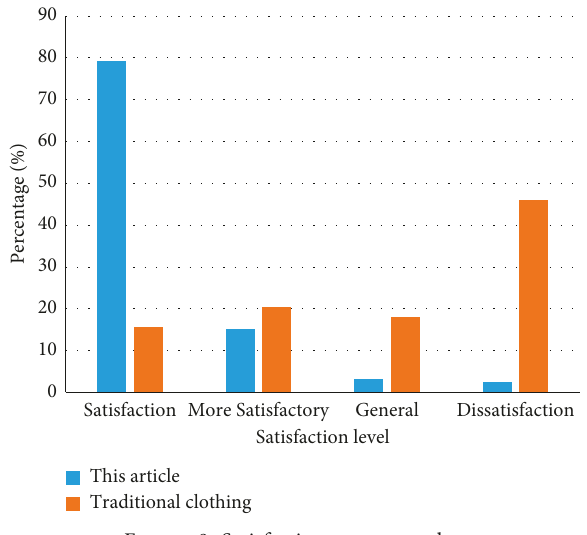
Figure 8: Satisfaction survey